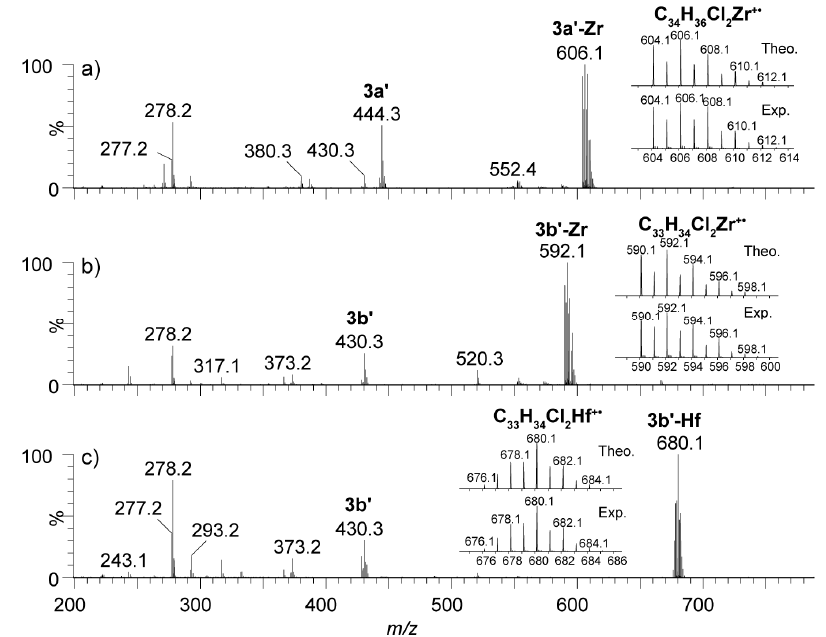
Figure 1. The APPI(+) mass spectra of the mononuclear complexes 3a’-Zr ( a ), 3b’-Zr ( b ), and 3b’-Hf ( c ). The zoomed areas showcase the theoretical and experimental isotopic clusters. For each isotopic distribution, only the most intense isotope peak is labelled.